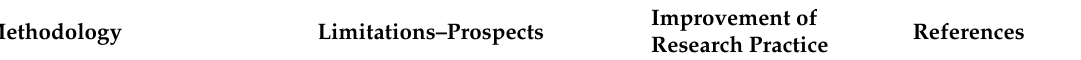
Table 1. Limitations and suggestions for improving research practices in relation to the biological activities